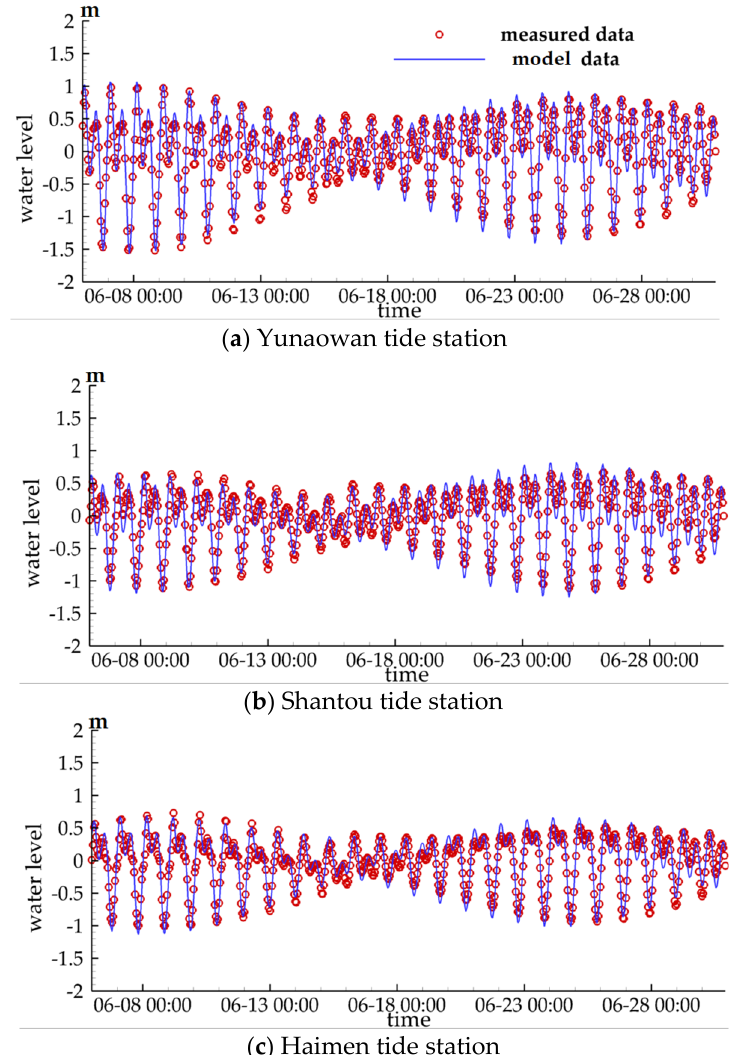
Figure 3. Verification results of tide level.